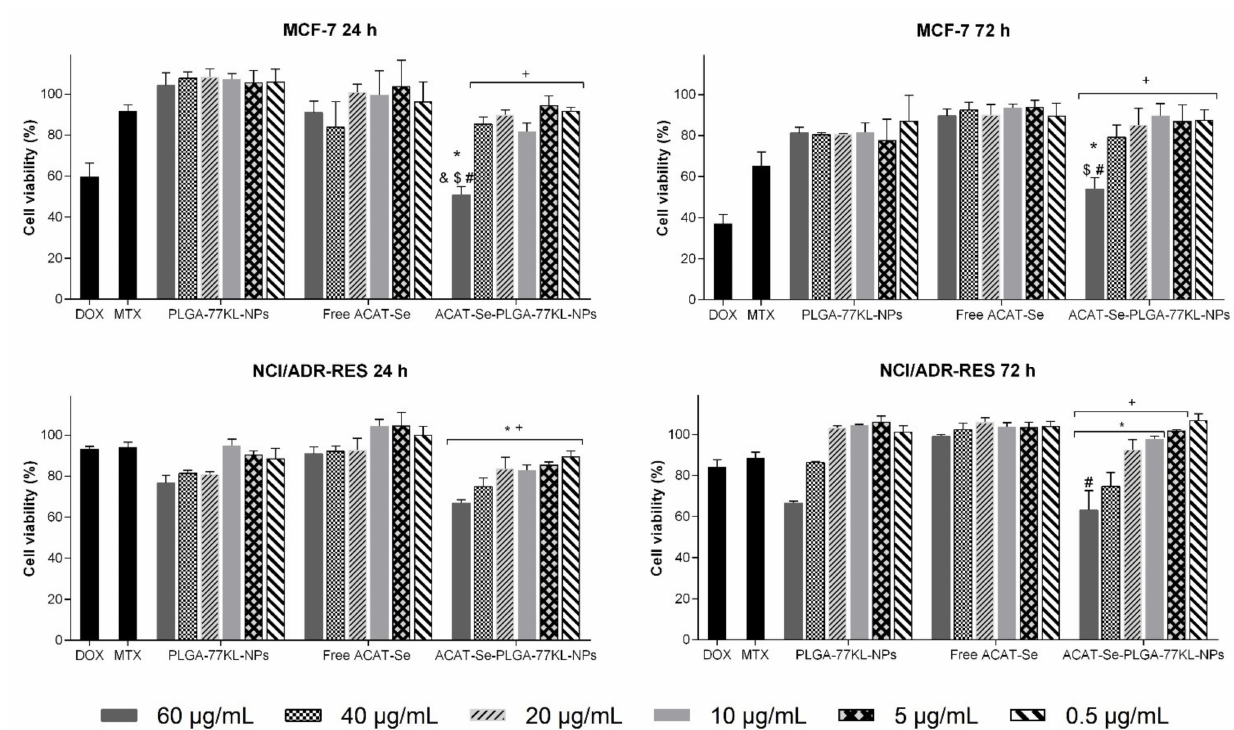
Figure 7. In vitro cell viability by NRU assay in MCF-7 and NCI/ADR-RES cell lines after 24 and 72 h of treatment. antitumor drugs MTX (50 µ g/mL) and DOX (10 µ g/mL) were used as positive controls. Data are expressed as mean of three independent experiments ± SE. Statistical analyses were performed using ANOVA followed by Student–Newman–Keuls multiple comparison